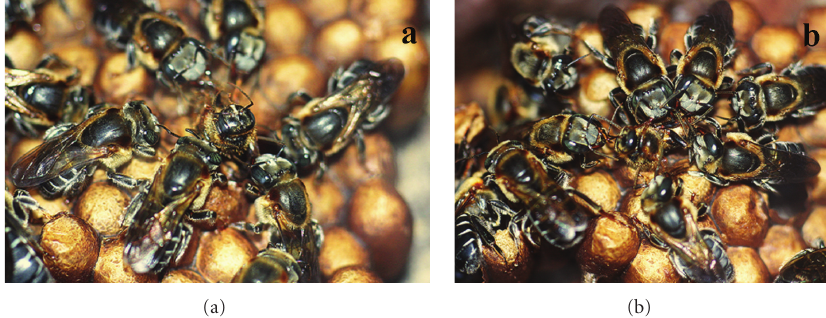
Figure 3: Melipona interrupta manaosensis, the workers’ behavior in colonies with a 1:1 sex ratio. Workers are attacking a male (a) and killing the queen (b) in the same colony at the same time. Table 2: Variation of the sex ratio in colonies of Melipona seminigra merrillae . Queens that produced diploid males (a 1 :1 sex ratio in the first brood comb) did not maintain this ratio in the second and third brood combs. Colony ♂ G